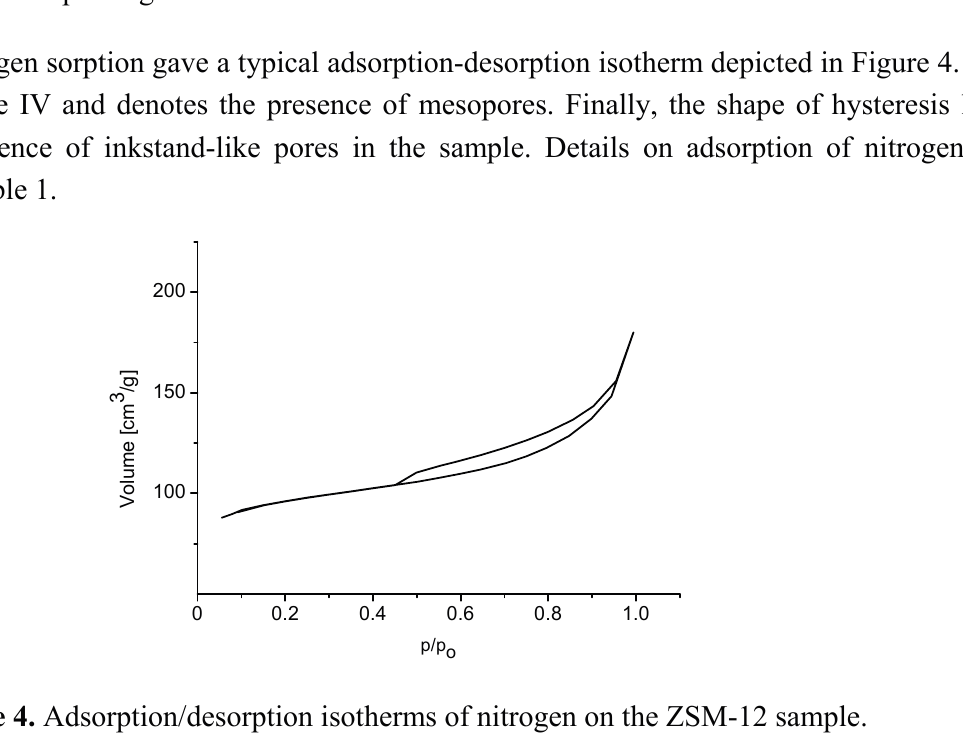
Figure 3. 27 Al MAS NMR spectra of the zeolite samples: (a) ZSM-12; (b) MCM-22; and (c) Beta. Spectra (a) and (b) were recorded at 300 MHz and spectrum (c) at 500 MHz. Asterisks denote spinning sidebands.